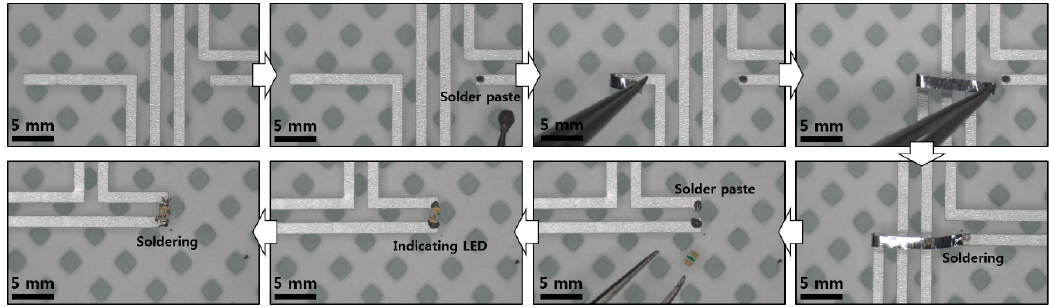
Figure A5 . Microscopic images of chip integration and Al connection. A fine tweezer, sharp needle,